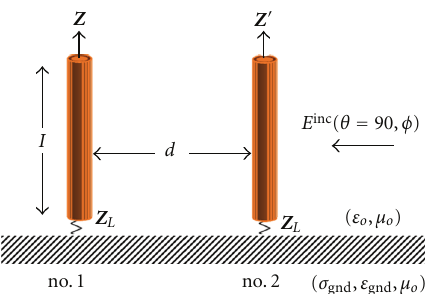
Figure 1: Setup for finding mutual coupling between monopole array over arbitrary